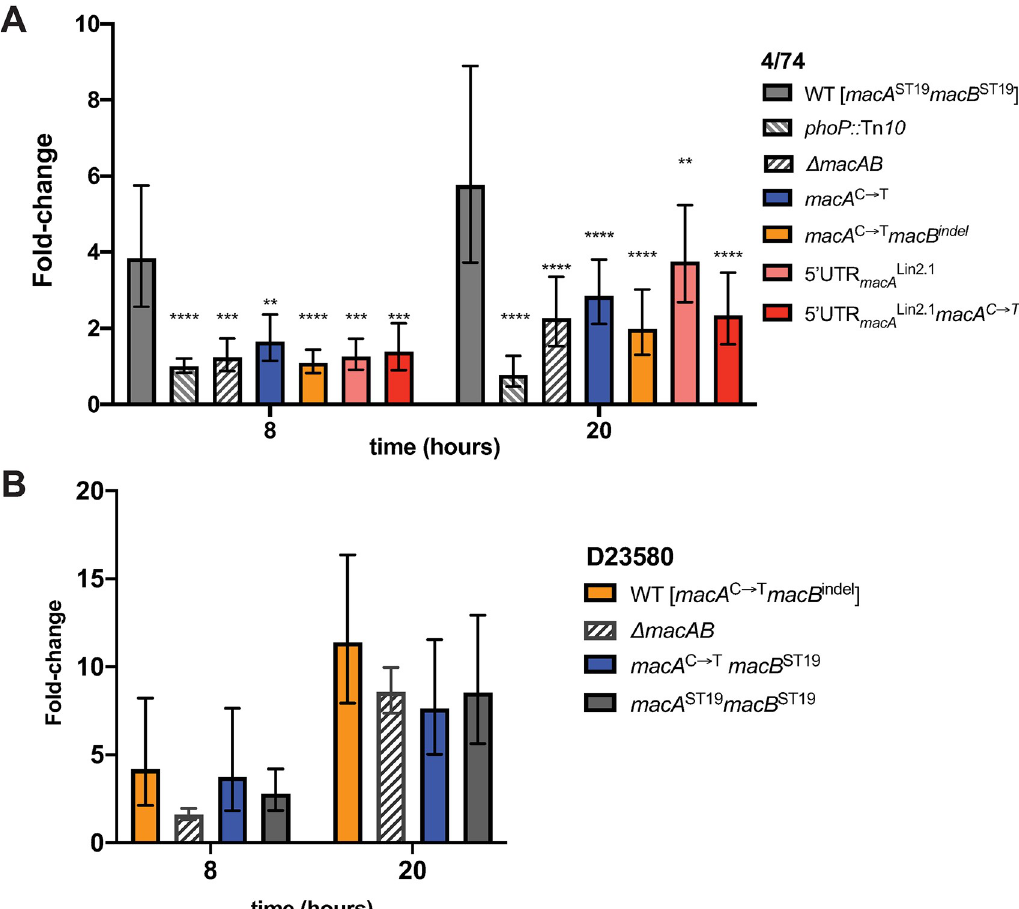
Fig 3. S . Typhimurium ST313 macAB variants impede ST19 4/74 replication in RAW macrophages. RAW264.7 cells were infected at an MOI of 10 with bacteria from overnight stationary phase cultures. Replication was assessed by plating bacteria at the indicated timepoints with fold-replication calculated relative to CFU/well at t = 0 as described in Materials and Methods. (A) S . Typhimurium ST19 4/74 with derived mutants, and (B) ST313 lineage 2 isolate D23580 with derived mutants. Two-way ANOVA (time, strain) with Dunnett’s post-test comparing each mutant to the parent strain; bar = geometric mean; error bars = geometric standard deviation. �� = p < 0.01, ��� = p < 0.001, ���� = p <